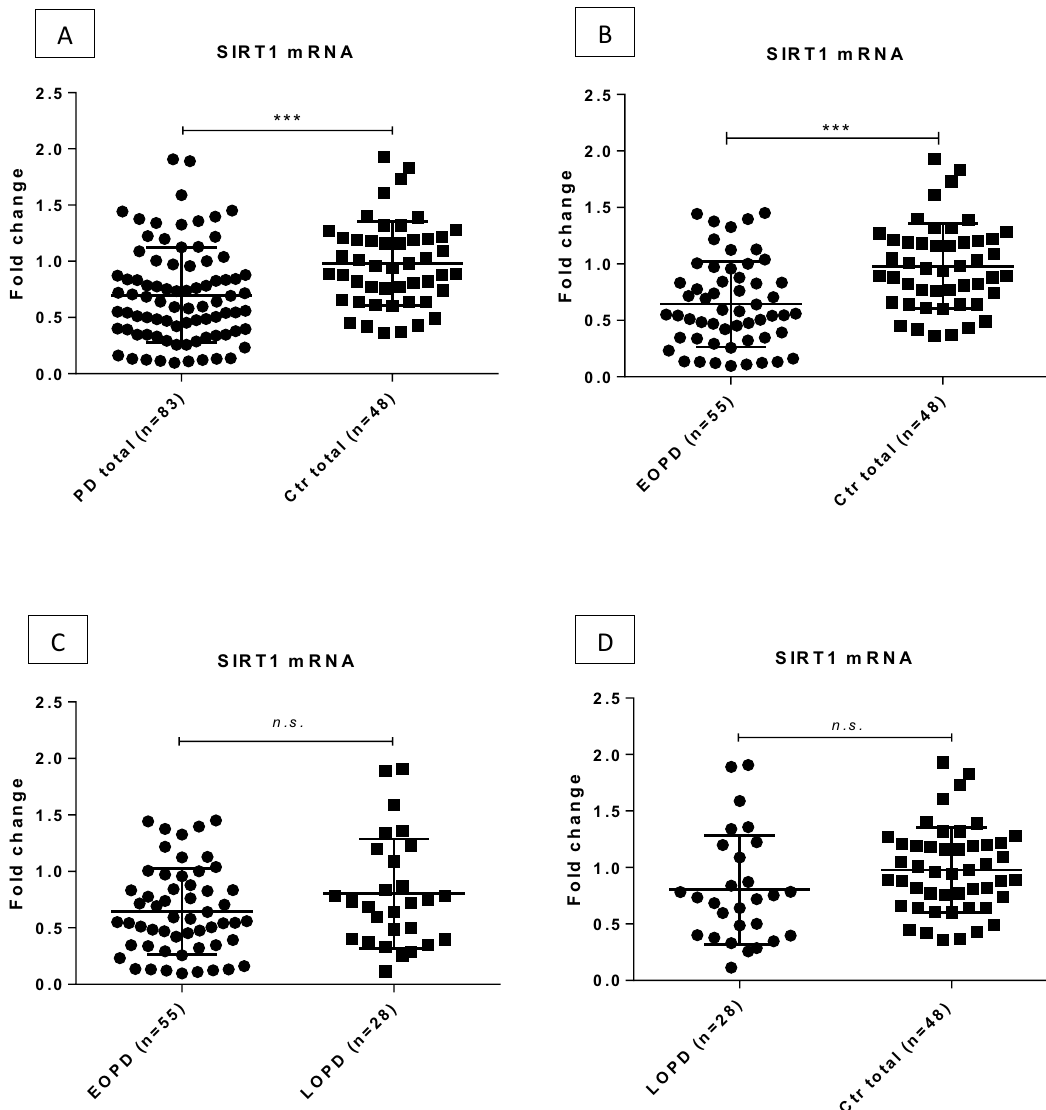
Figure 2. Expression level of SIRT1 in the peripheral blood of PD patients and healthy controls. Significant down-regulation of SIRT1 expression was measured in PD group compared to controls ( A ), and in EOPD patients compared to controls ( B ) as well. No significant difference was detected in the case of EOPD vs. LOPD ( C ) and LOPD vs . control group ( D ) comparisons. Fold changes are shown with standard deviation.